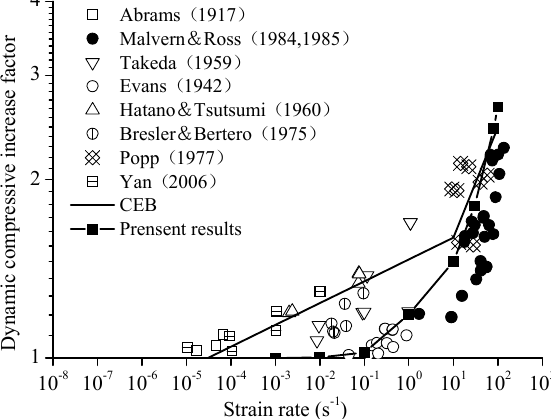
Figure 14. The effect of strain rate on compressive strength of plain concrete.